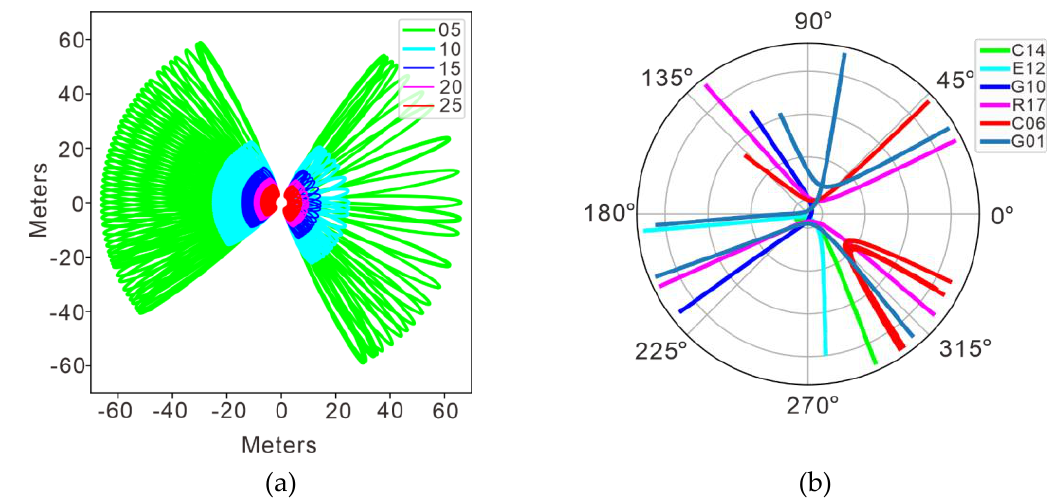
Figure 5. Reflection region and reflection point track: ( a ) Fresnel reflection region around P387 station; ( b ) ground motion trajectory of reflection points around P387 station.